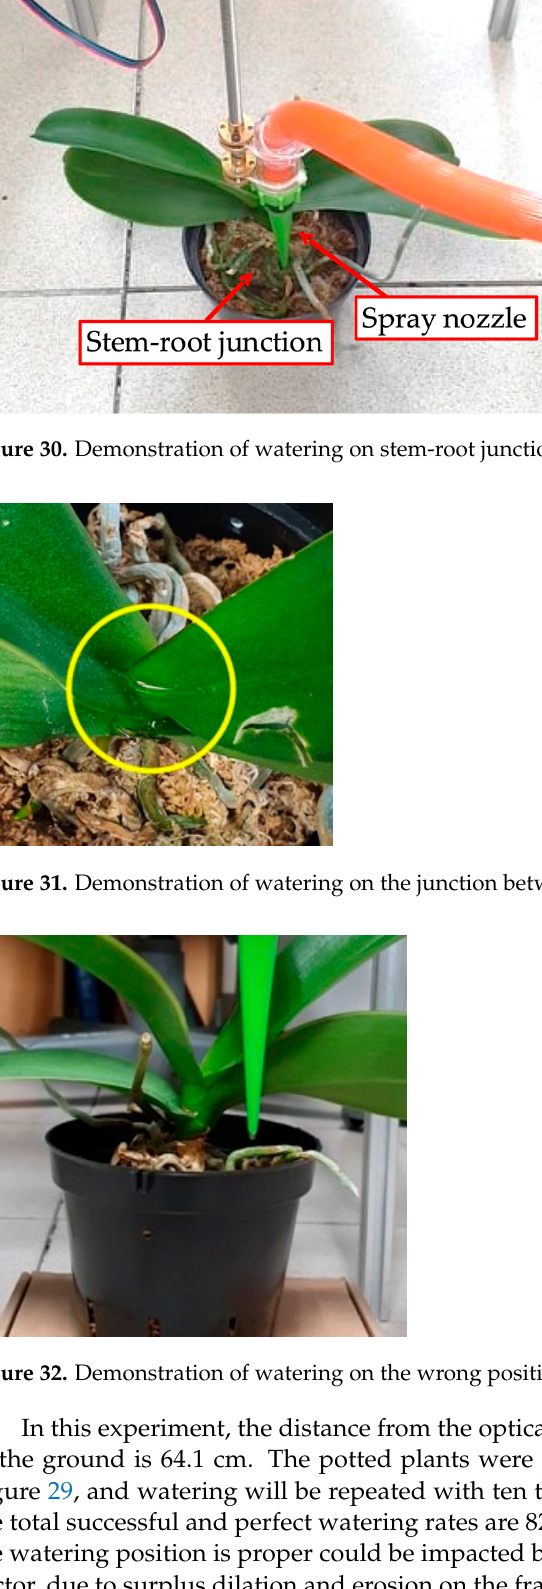
(6) Figure 33. The pot holder for the multiple-seedling experiments.